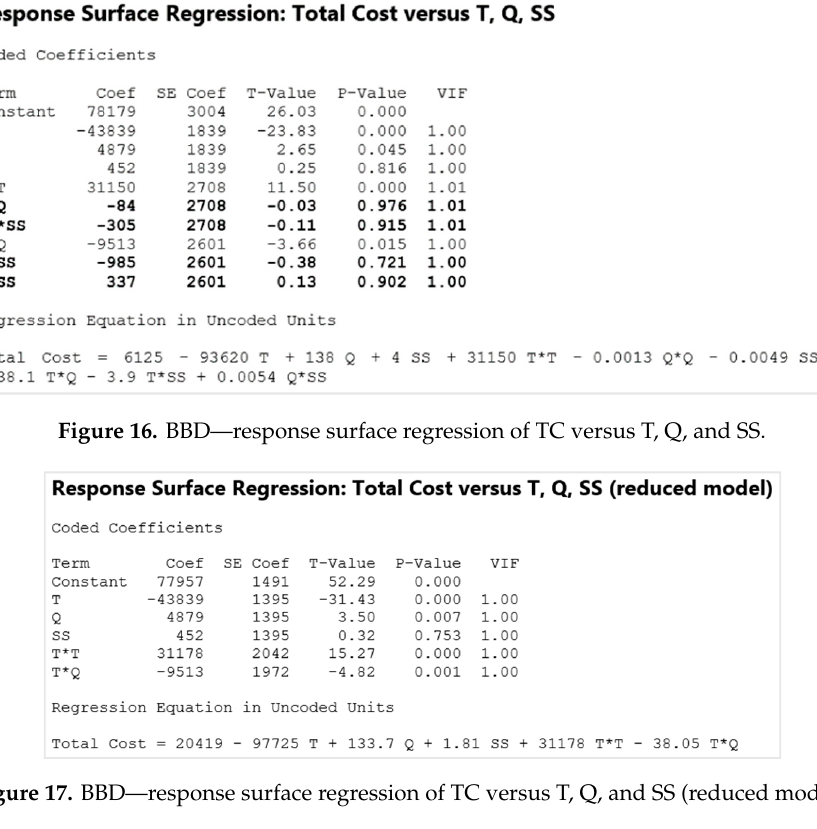
Figure 17. BBD—response surface regression of TC versus T, Q, and SS (reduced model).